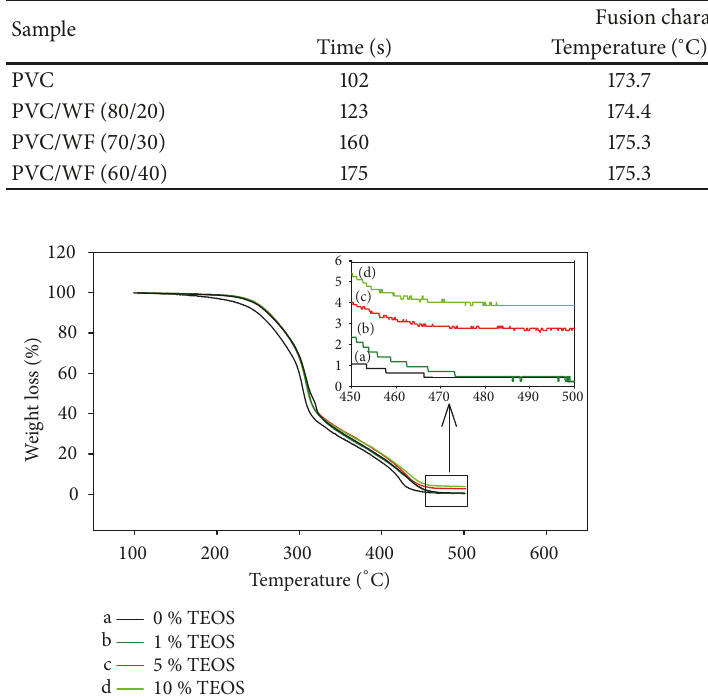
Figure 5: TGA curves of (a) WF and WS with contents of (b) 1, (c) 5, and (d) 10 wt% TEOS.